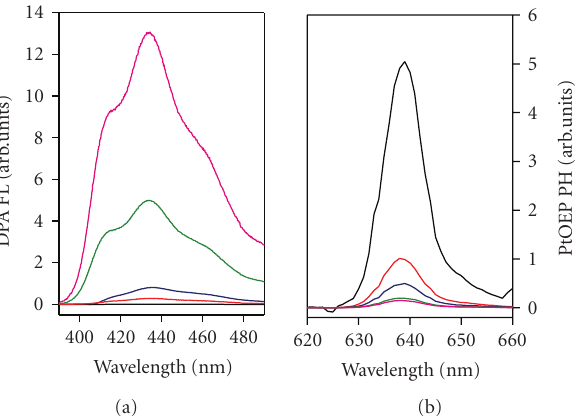
(M)0 . 001 Acceptor concentration